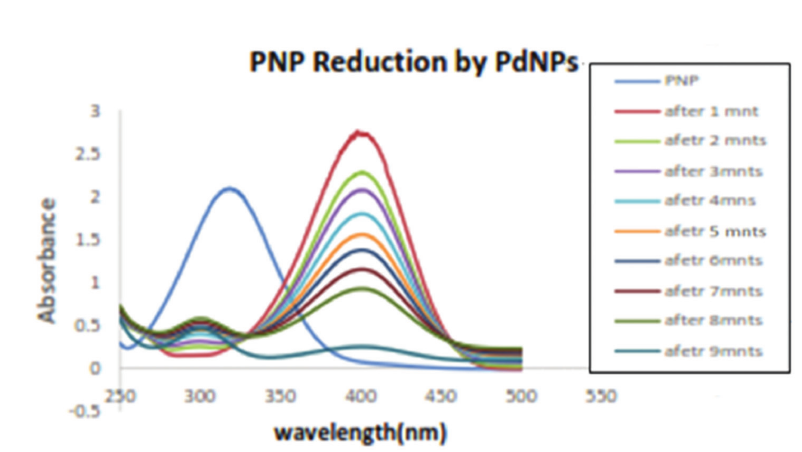
Figure 11: 4NP reduction by PdNPs in 9 mints.